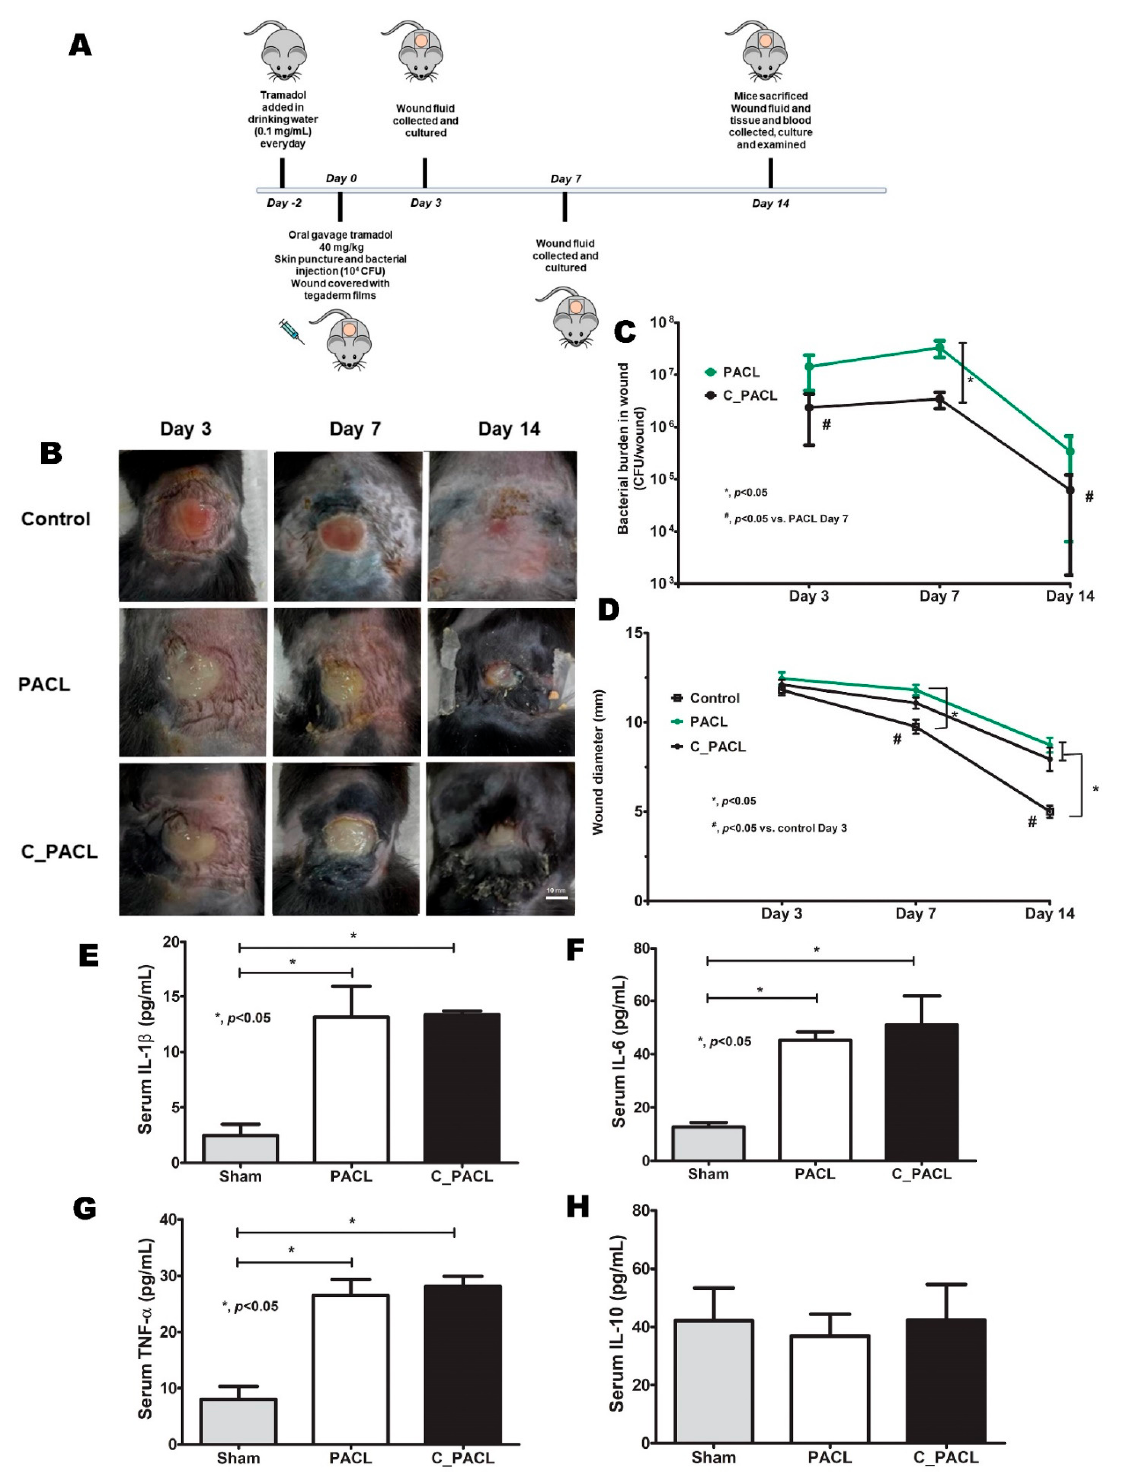
Figure 10. The characteristics of wounds from P. aeruginosa parent strain (PACL) and Chlorhexidine (CHG)-treated strain (C_PACL); control (n = 8), PACL (n = 9), and C_PACL infection (n = 8), as indicated by diagram of experiments ( A ), the representative pictures of wounds ( B ), bacterial burdens in wounds ( C ), wound diameters ( D ), and the serum cytokines ( IL-1 β , IL-6 , TNF- α , and IL-10 ) at 14 days of experiment ( E – H ) are demonstrated. Mean ± SEM are presented with the one-way ANOVA followed by Tukey’s analysis (*, p < 0.05 and # , p < 0.05 considered statistically